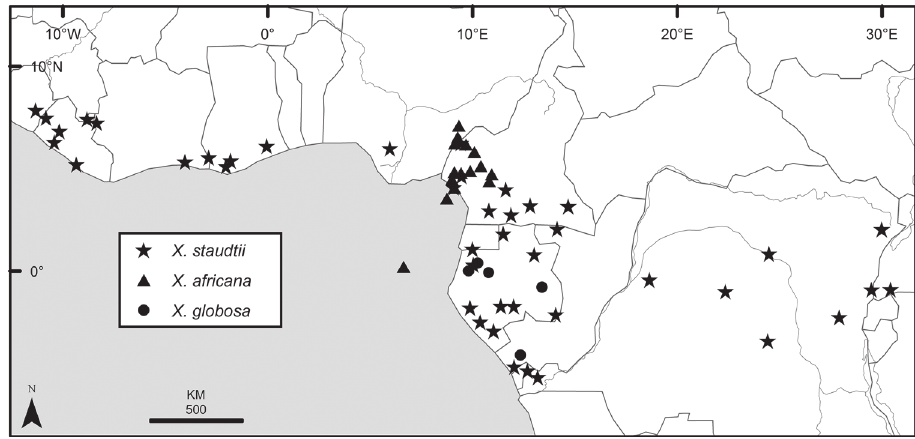
Figure 10. Distributions of Xylopia africana , X. globosa , and X. staudtii . Bolder lines represent country borders, fainter lines lakes and major